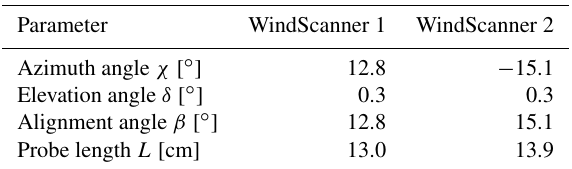
Table 2. Setup parameters describing the WindScanner staring mode scan.